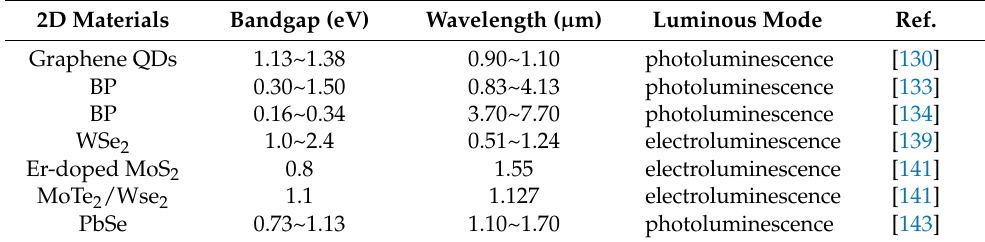
Table 2. 2D material candidates for LEDs